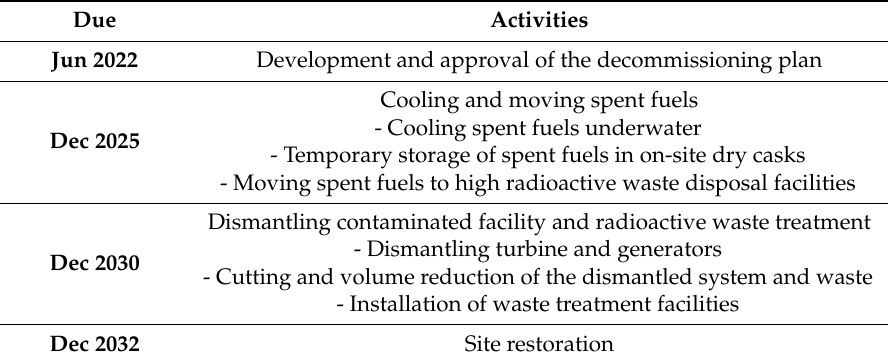
Table 1. Decommissioning schedule for Kori-1